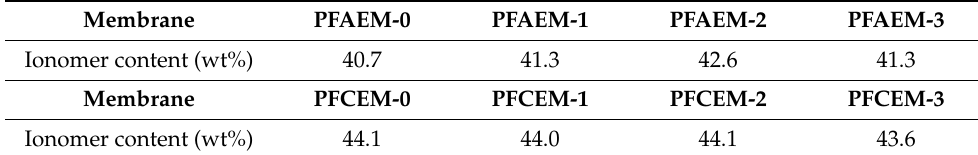
Table 3. Ionomer contents in prepared PFIEMs.